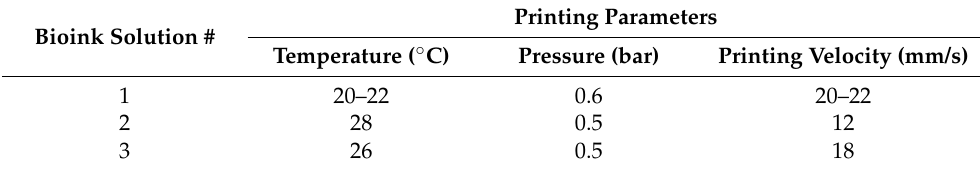
Table 2. Printing parameters of cell-laden, core bioink